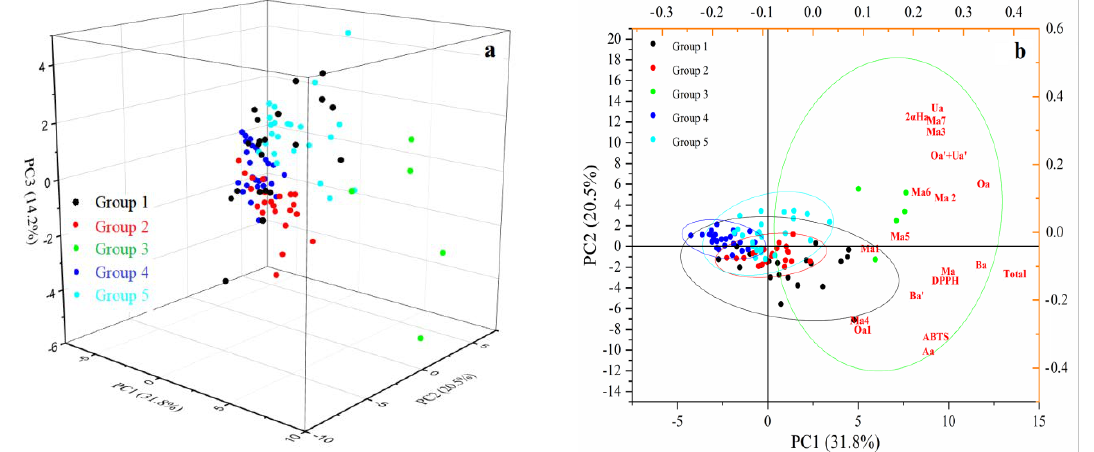
Figure 6. The 3D plots ( a ) and biplots ( b ) of PCA. Groups 1, 2, 3, 4, and 5 are the classified clusters of jujube by HCA. The ellipses with different colors represent the 95% confidence ellipse for different clusters.